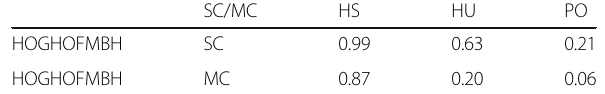
Table 4 d-mAP scores for the HOGHOFMBH models on UT- Interaction. In columns the true class, in rows the tested class. Addition interactions from UT-Interaction include kick (KI), point (PT), punch (PC), and push (PS) HS HU KI PT PC PS HS 0.21